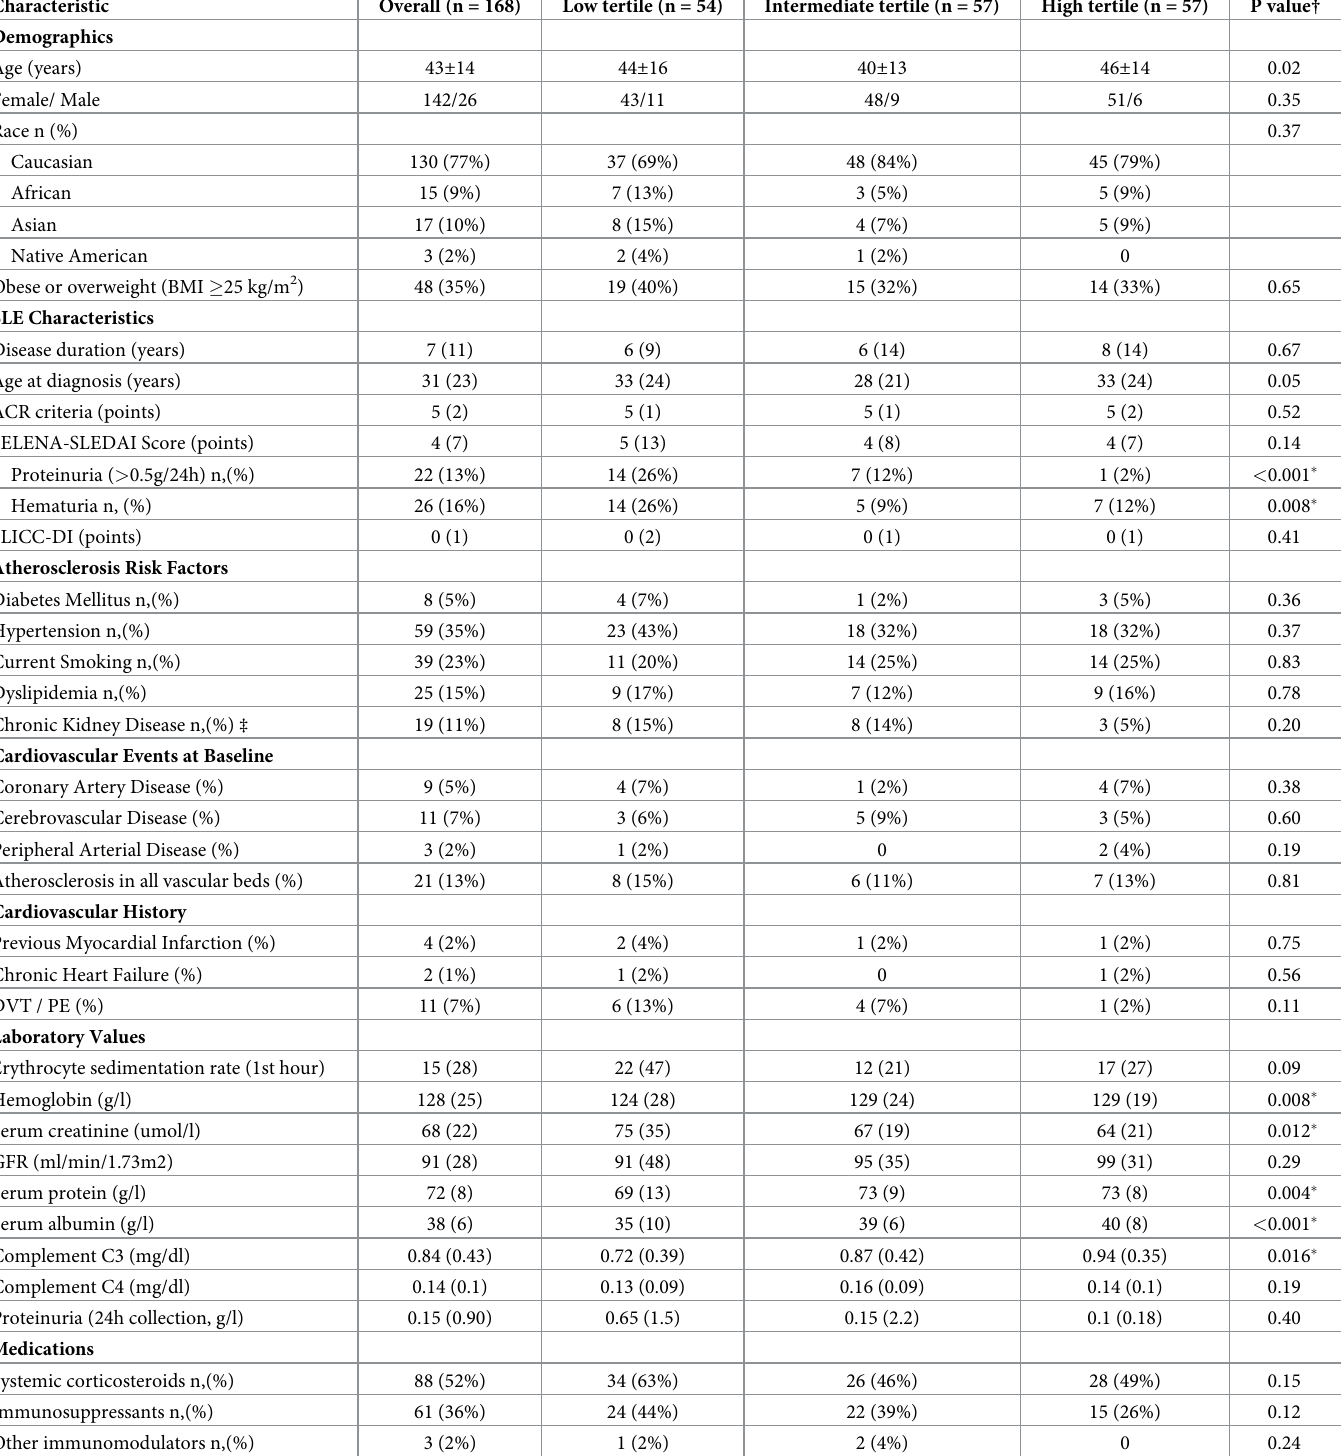
Table 1. Baseline characteristics at enrollment in the study